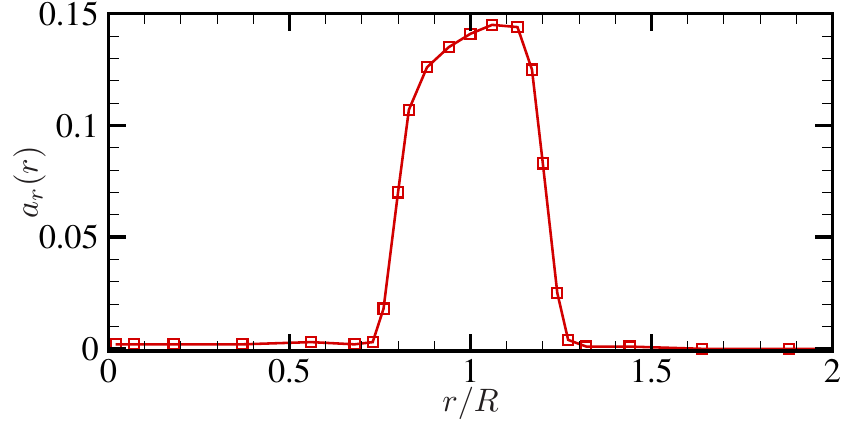
Figure 4. The radial distribution of the average induction